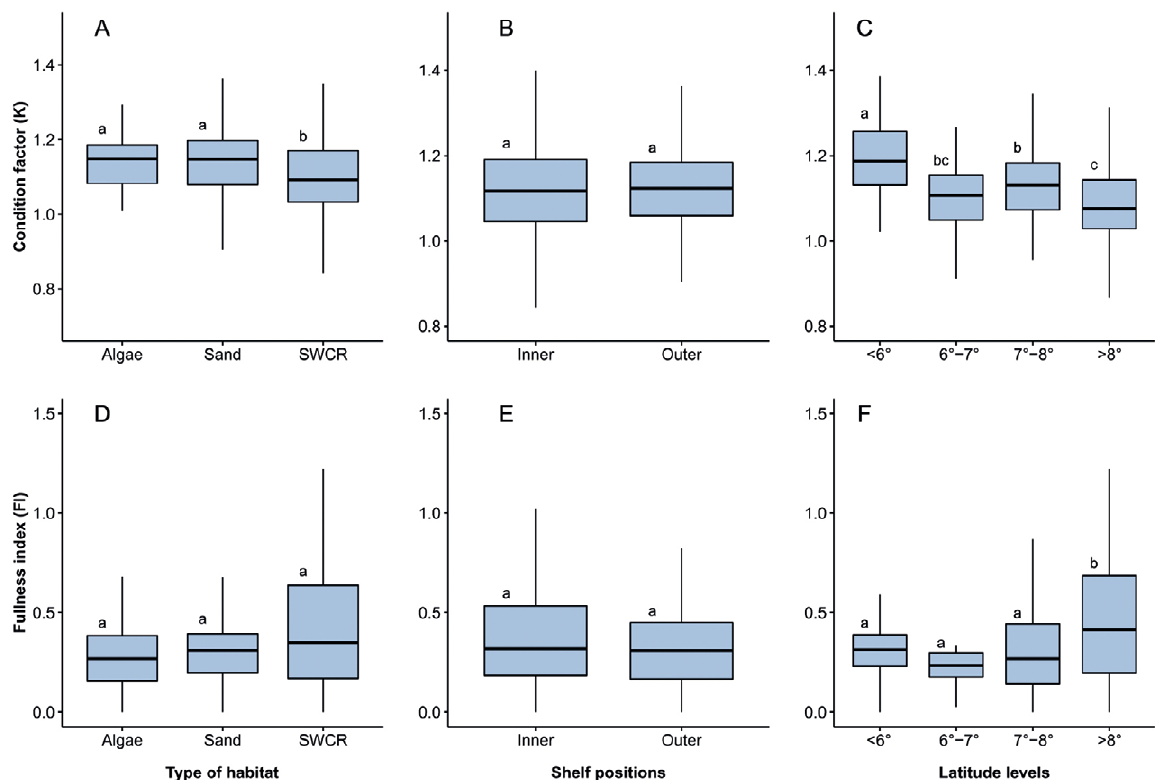
Fig. 5. – Condition factor (K) and fullness index values (FI) of P. maculatus in different habitats, latitude levels and shelf positions. The black horizontal line and box represent the median value and the interquartile range, while the vertical lines represent the upper and lower limits. Outliers were not included in the plot. Different letters mean significant